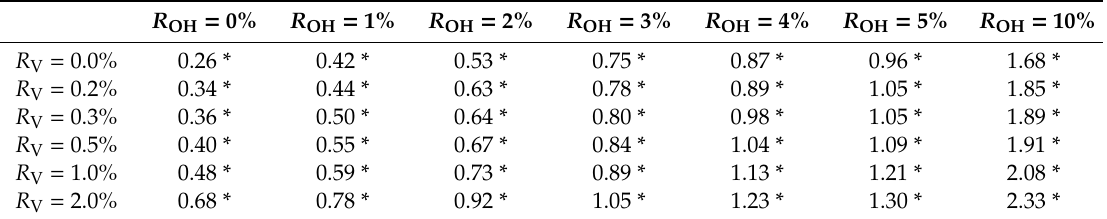
Interfacial thermal conductance of GO with di ff erent ratio of hydroxyl groups and vacancy